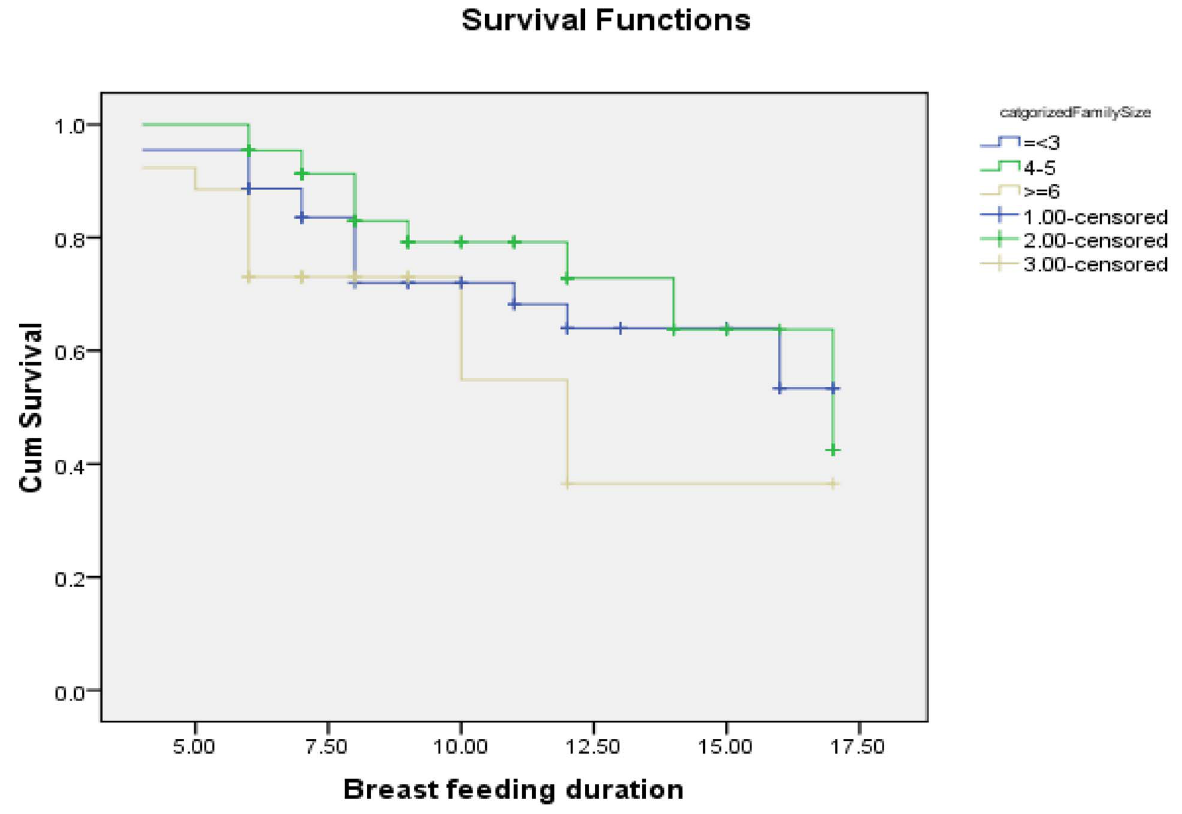
Figure 3. Survival function of breastfeeding duration stratified based on bottle feeding practices of HIV positive mothers in Sidama Zone, Southern Ethiopia, 2012.